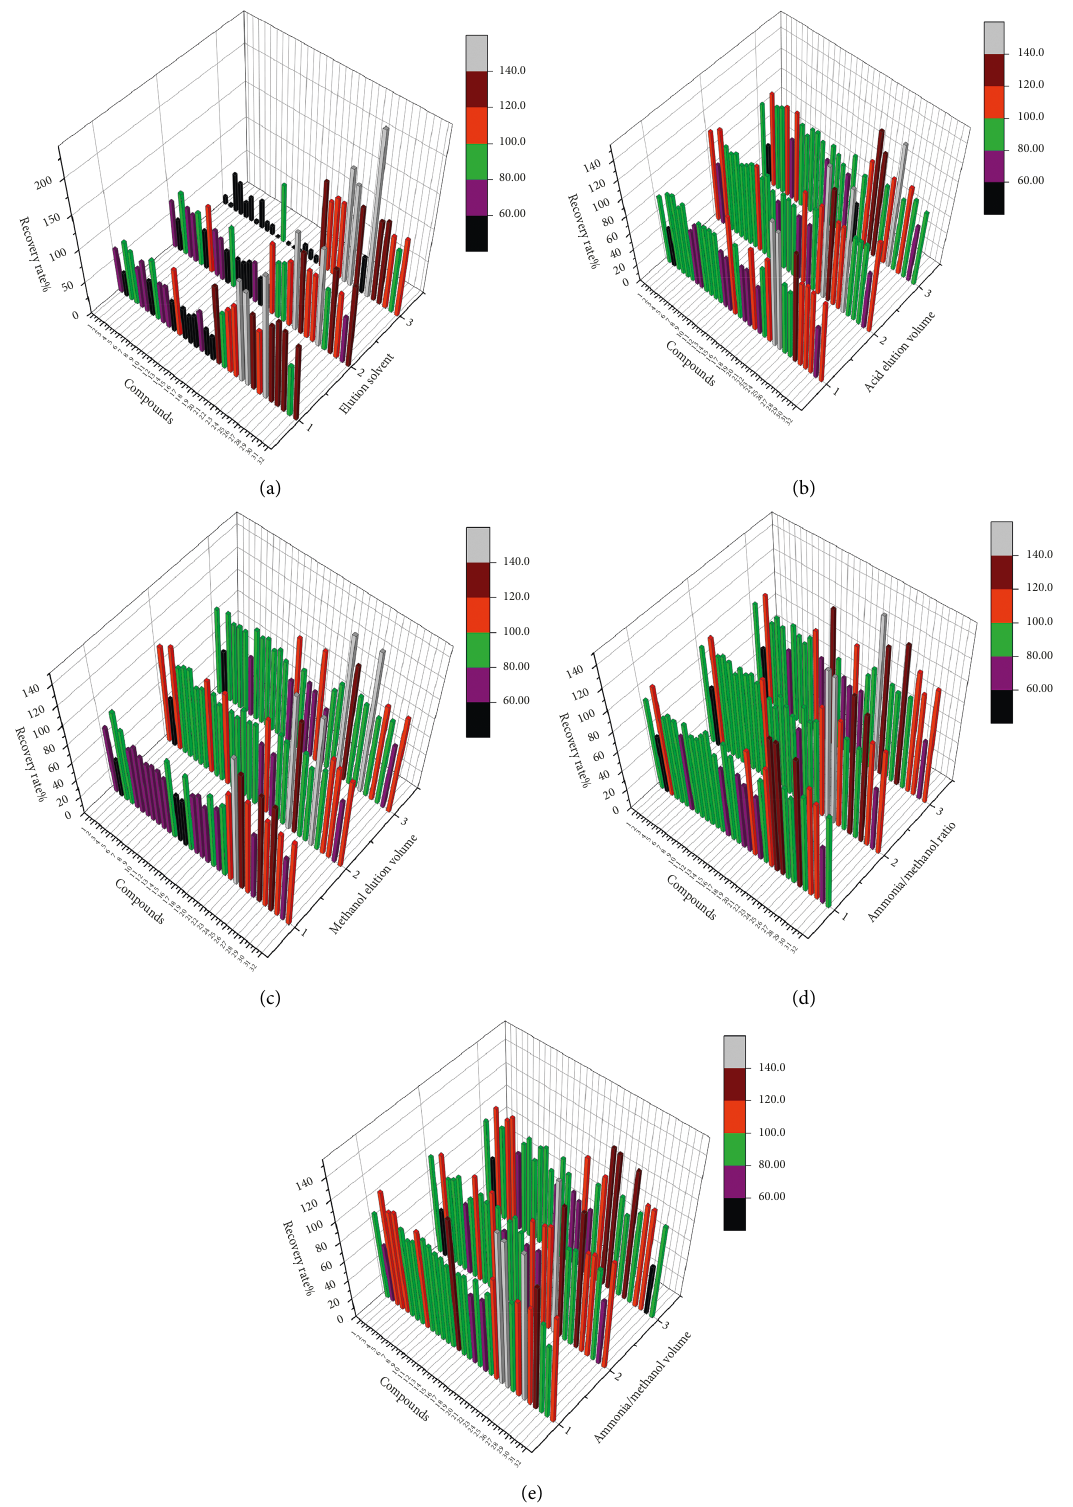
Figure 5: Selection results of CDDP preparation pretreatment formula. (a) Elution solvent selection result. (b) Acid elution volume selection result. (c) Methanol elution volume selection result. (d) Ammonia/methanol elution ratio selection result. (e) Ammonia/methanol elution volume selection result. X -axis: 1 . Em, 2 . Er, 3 . Eu, 4 . He, 5 . Ic, 6 . Im, 7 . Jb, 8 . Lc, 9 . Ly, 10 . Mc, 11 . Re, 12 . Sk, 13 . Sn, 14 . Sp, 15 . Sv, 16 . Td, 17 .7-Ly, 18 .7-Im, 19 . EmNO, 20 . ErNO, 21 . EuNO, 22 . HeNO, 23 . IcNO, 24 . ImNO, 25 . JbNO, 26 . LcNO, 27 . LyNO, 28 . McNO, 29 . ReNO, 30 . SnNO, 31 . SpNO, 32 .